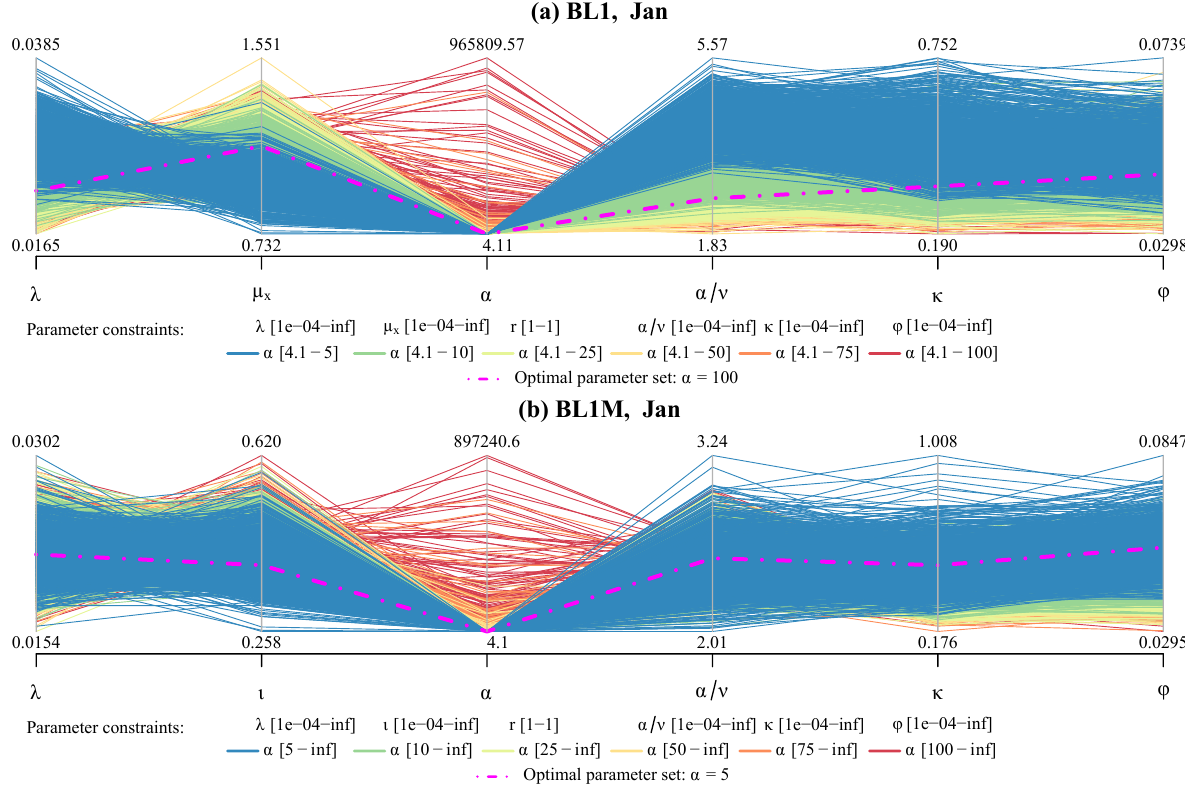
Figure A1. Parallel coordinate plots for the two randomized Bartlett–Lewis rectangular pulse models, BL1 and BL1M. Plots show the range of Jan parameter values for uncensored models fitted to Bochum 15min rainfall. The dashed magenta lines show the parameter sets corresponding to α = 100 and α = 5 for the BL1 and BL1M models